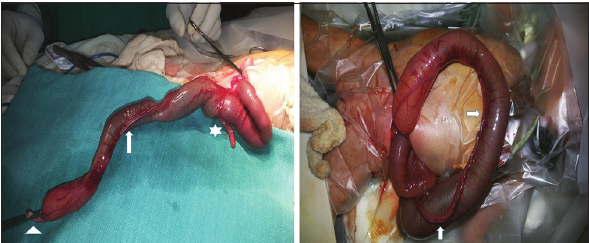
Figure 1: Entire colon, devoid of its mesentery, tinea coli,